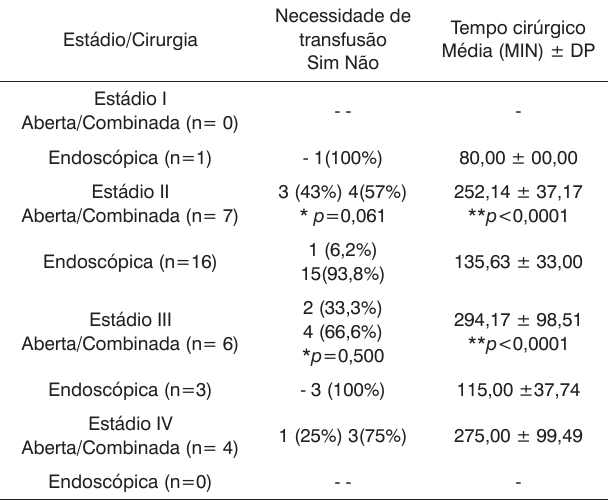
Tabela 4. Associação entre o tipo de cirurgia com os estádios tumorais. Jan 2001/Jul